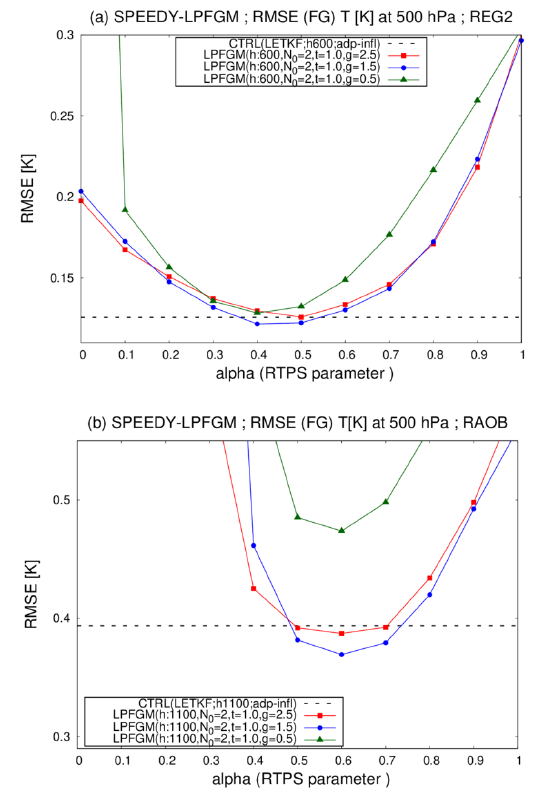
Figure 15. Time-mean background RMSEs for T (K) at the fourth model level ( ∼ 500hPa) as a function of RTPS parameter α , averaged over three months of the third year (February–April); (a) shows REG2 with 600km localization scale, and (b) shows RAOB with 1100km localization scale. Red, blue, and green lines are LPFGM experiments where γ = 2 . 5, 1.5, and 0.5, respectively. Black dashed lines represent RMSE of LETKF (0.1257K) with adaptive multiplicative inflation instead of RTPS. Other parameters are set to be the best-performing parameters: N 0 = 2 and τ = 1 .